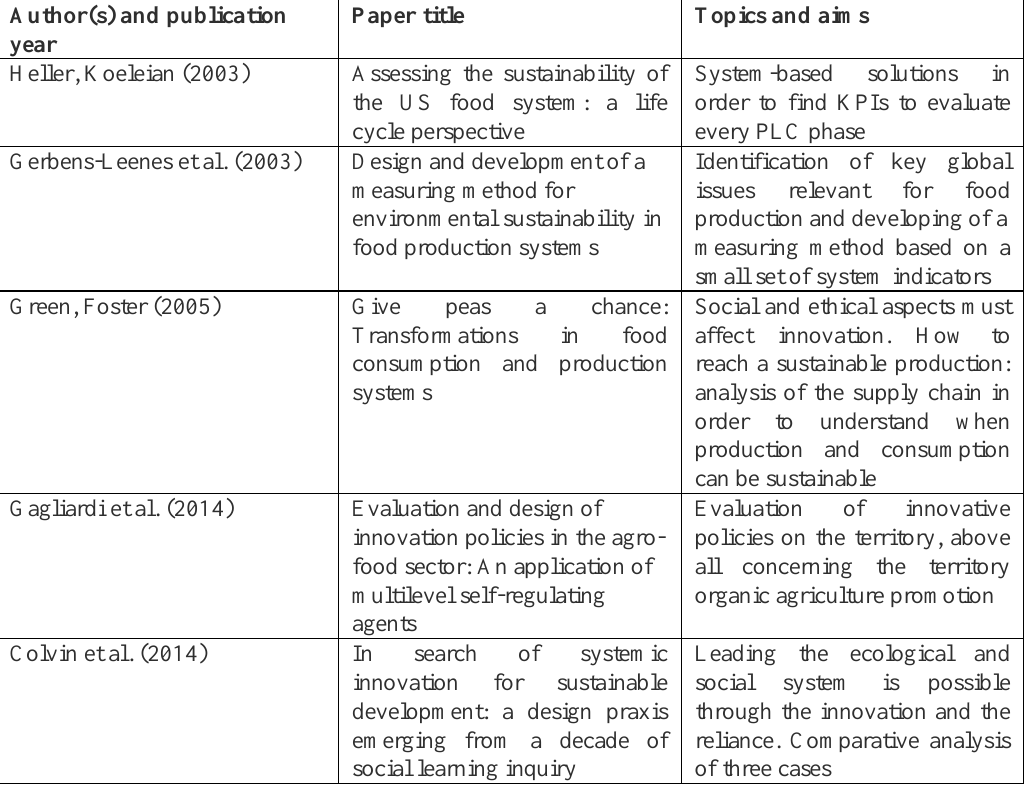
Table 1: Instances of valid attempts in food sustainable